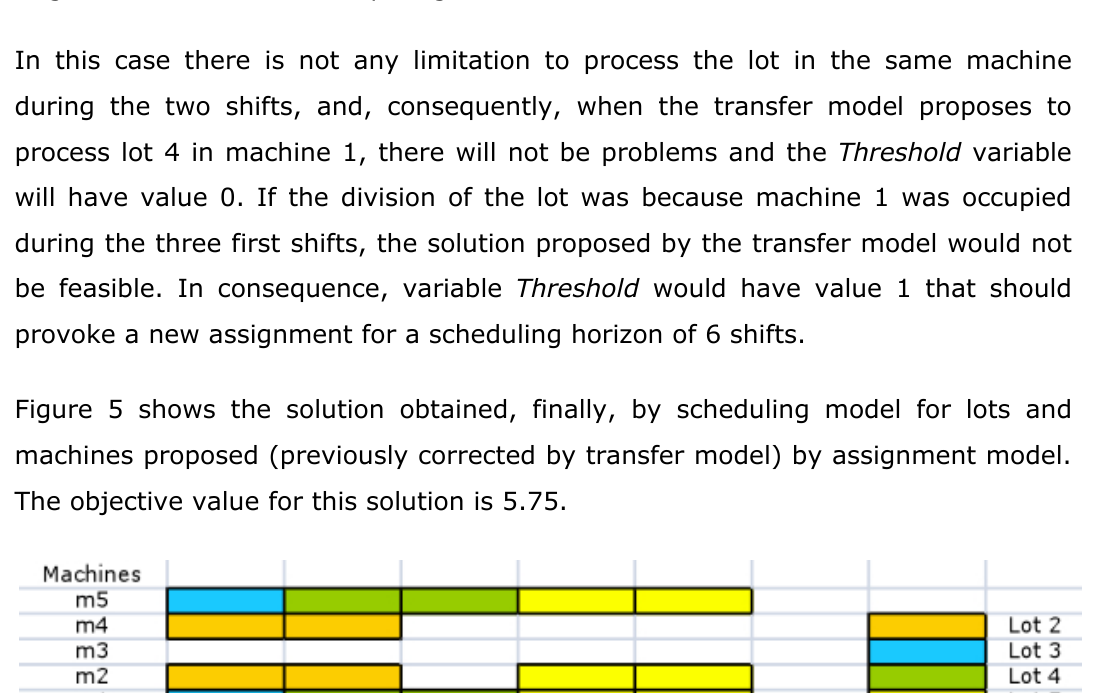
Figure 4. “Solution obtained by assignment model on instance number 5”. Source: Authors